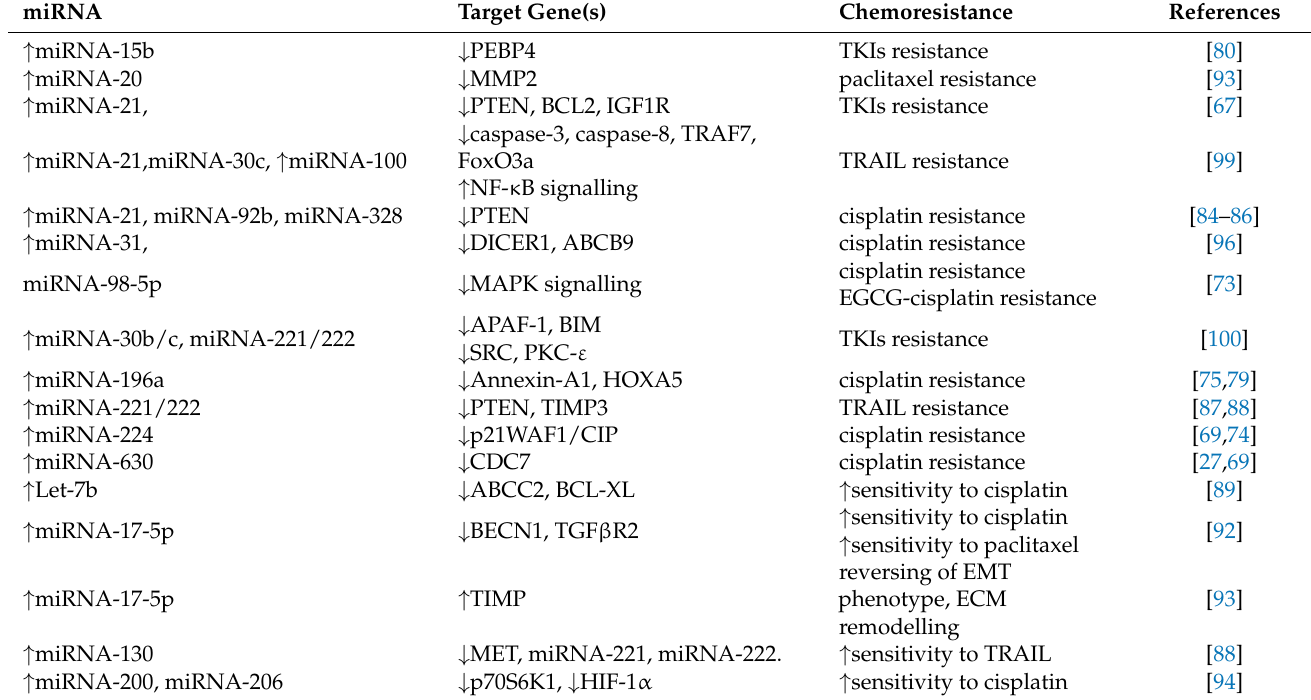
Table 1. MiRNAs involved in drug resistance regulation in